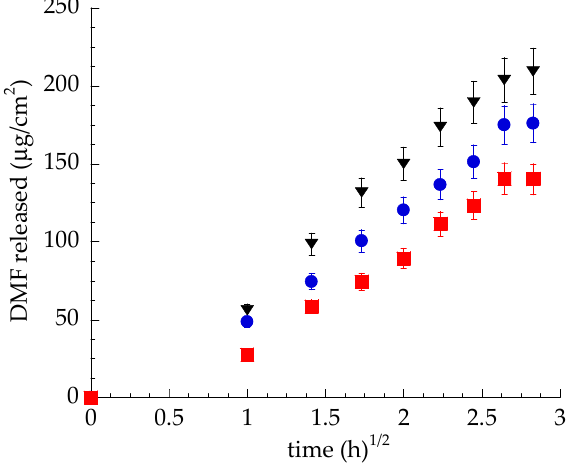
Figure 2. Effect of storage on ethosomes and transethosomes kept at 22 °C for 3 months: ( a ) Z aver- age mean diameters measured via PCS on TET 0 . 9 (o), TET 0 . 9 -DMF ( • ), TET 2 . 7 ( □ ), and TET 2 . 7 -DMF ( ▪ ), p values < 0.05; ( b ) DMF residual content in T-ETO 0 . 9 -DMF ( • ), T-ETO 0 . 9 -DMF ( ▪ ) and SOL-DMF ( ▼ ). The percentage refers to the total DMF content evaluated after sample preparation; p values < 0.05.